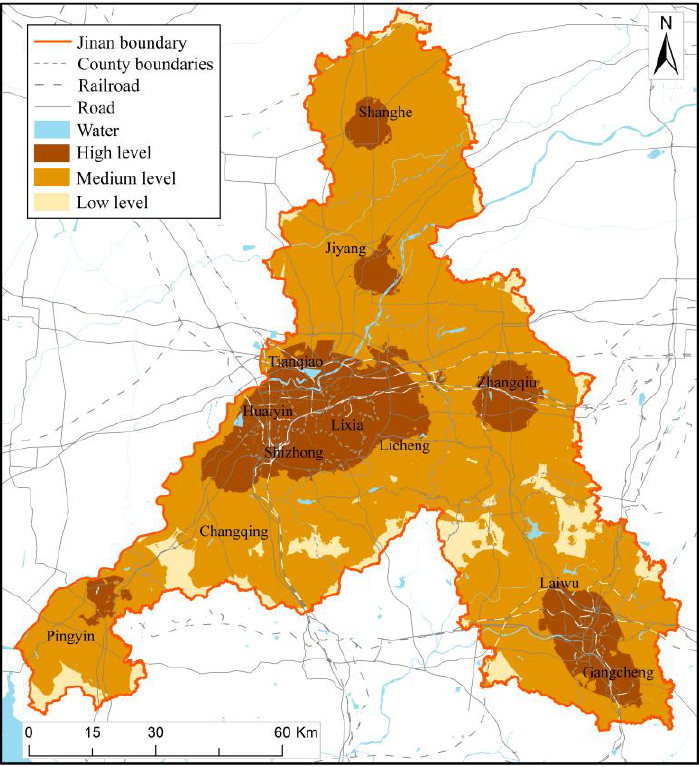
Figure 6. Result map of resilience assessment.